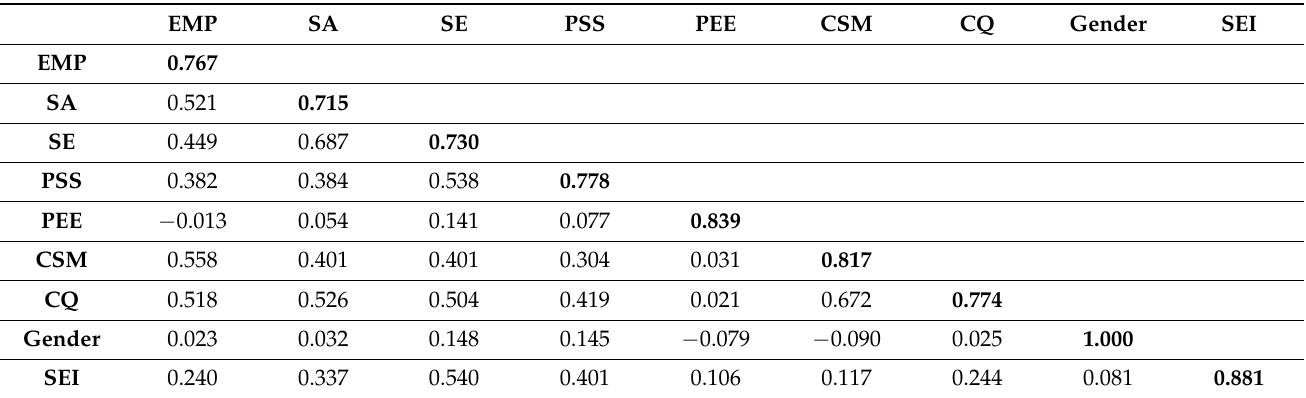
Table 6. Pre-pandemic inter-correlation matrix.